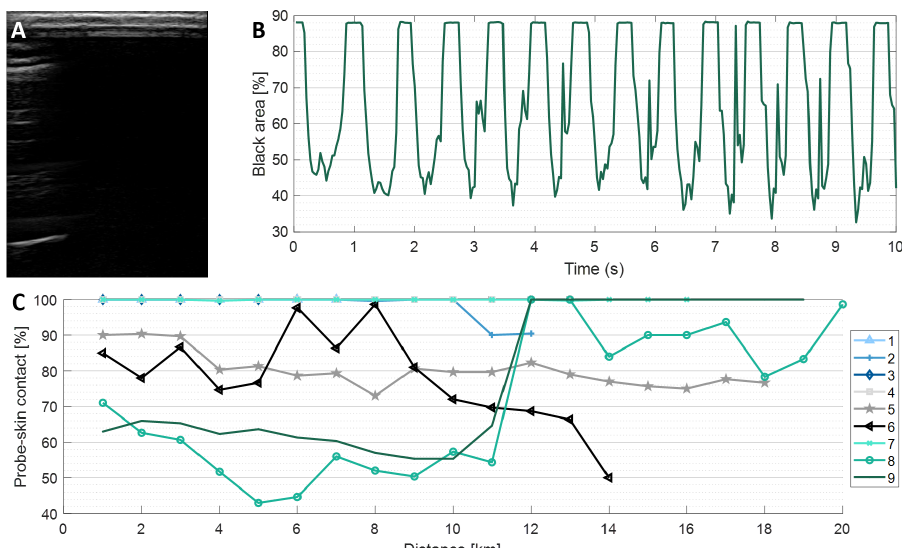
Figure 3. Probe-skin contact. ( A ) An example of an ultrasound image obtained during probe-skin contact loss. The right part of the frame shows a total reflection artifact, caused by a big difference in acoustic impedance between the ultrasound probe and the air. At the left side, some probe-skin contact is still preserved. ( B ) A representative example of an acquisition during which probe-skin contact loss occurred. Probe-skin contact was defined as an ultrasound frame consisting of less than 80% black pixels. This example was acquired during the first kilometer of volunteer 9. As shown in the subfigure, contact loss occurs cyclically during the same phase of the gait cycle, which was the case in all volunteers with probe-skin contact loss. ( C ) The percentage of frames within the acquisition that was obtained with preserved probe-skin contact. In four subject, probe-skin contact was preserved during the entire measurement. In the other five volunteers, the probe was in contact with the skin during 43–100% of the gait